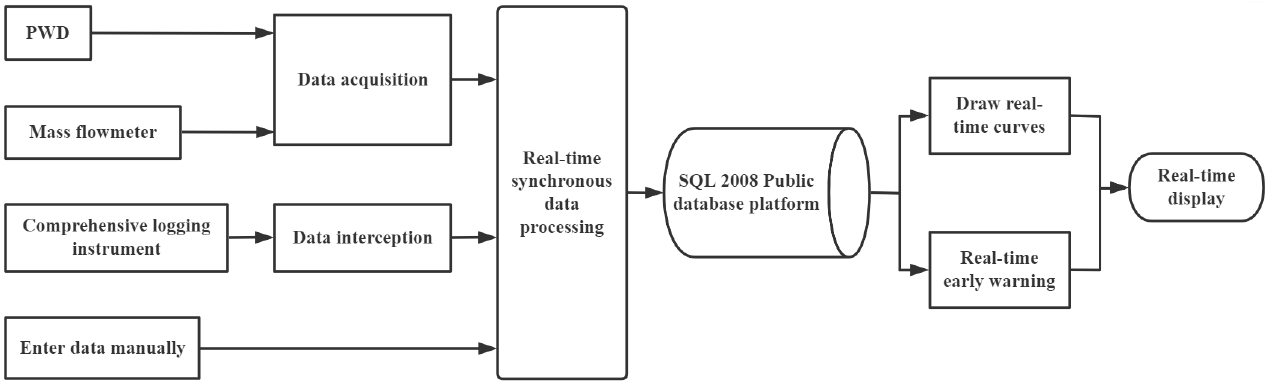
Figure 6. Software